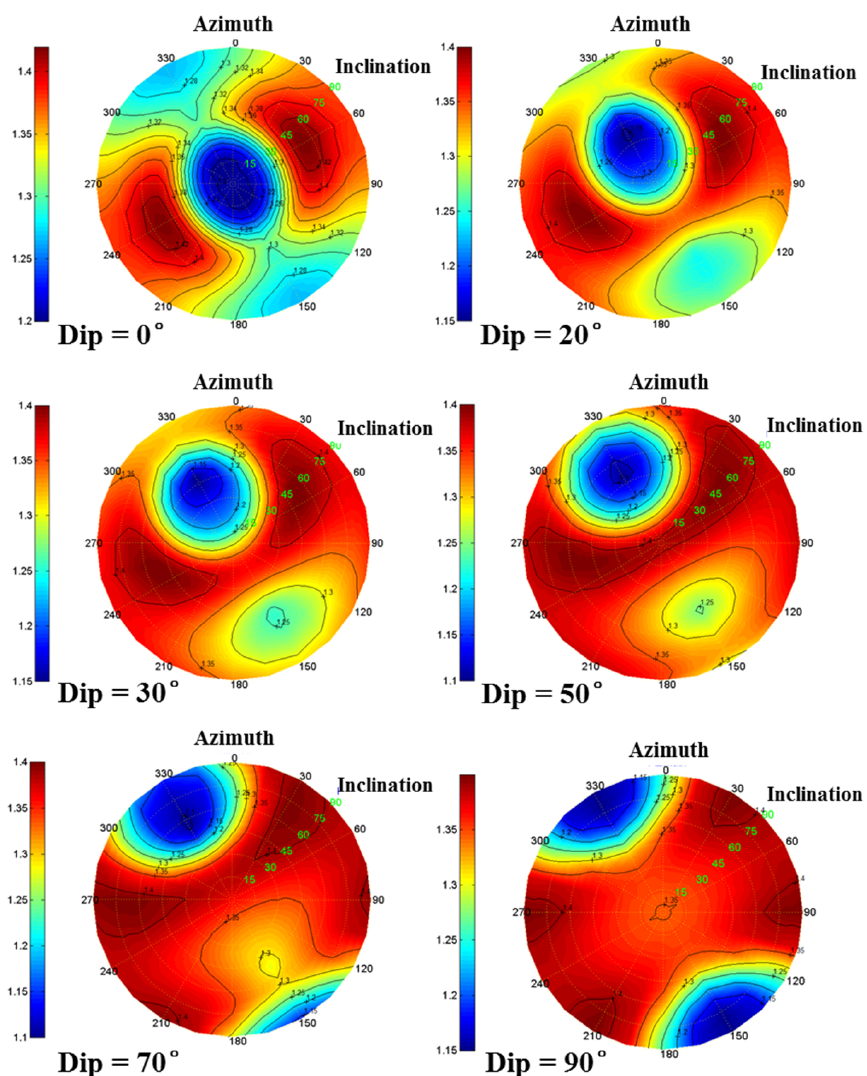
Figure 8. Collapse pressure for different inclinations and azimuths of borehole and dip angles of bedding planes (dip direction of bedding plane is at 150°; direction of the minimum horizontal stress is at 60°).